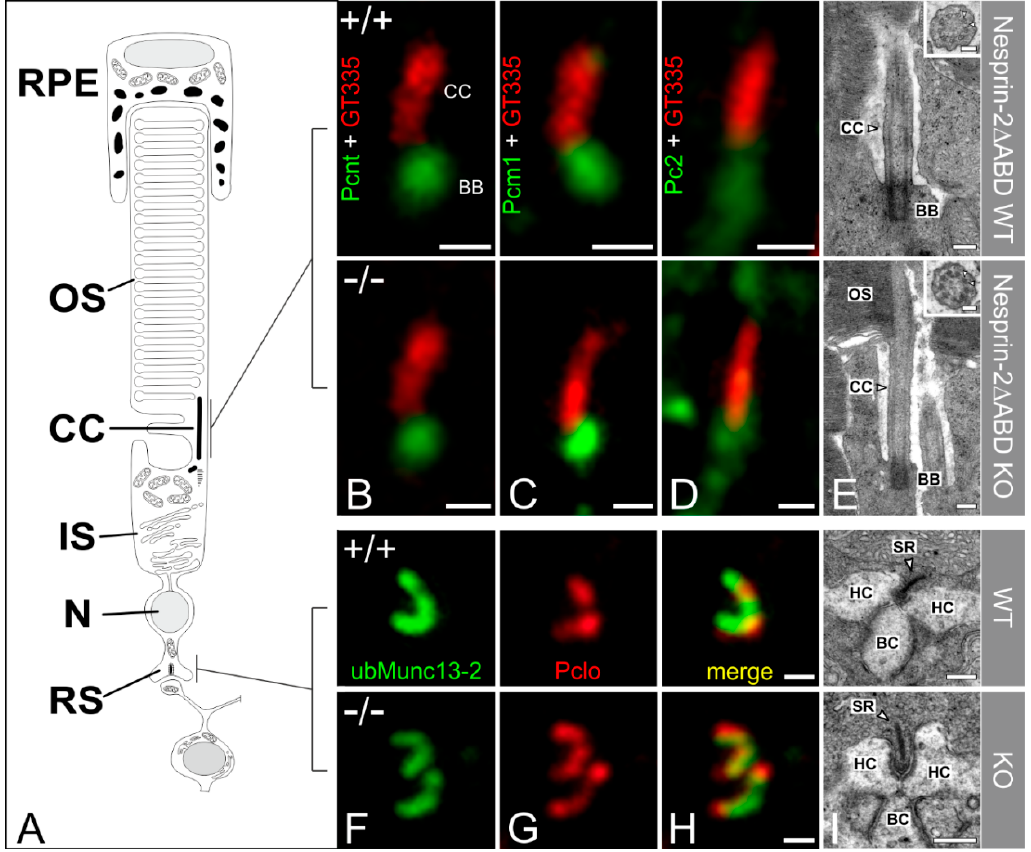
Figure 3. High-resolution microscopical analysis of the basal body complex and the ribbon synapse of Nesprin-2 (cid:52) ABD mouse strain (age 2–4 month). ( A ) Scheme of a vertebrate rod photoreceptor. ( B – D ) Photoreceptors connecting cilia (CC) of wild-type and knockout Nesprin-2 ∆ ABD mouse retinae double-labeled with antibodies against Pcnt (B, MmPeriC1, green), Pcm1 (C, green), or Pc2 (D, green) as markers for the basal body complex (BBC) and polyglutamylated tubulin (GT335, red) as a marker for the ciliary apparatus. Pcnt and its interaction partners are localized at the BBC of the connecting cilium of the photoreceptor in wild-type and knockout Nesprin-2 ∆ ABD retinae. ( E ) Representative electron micrographs of rod photoreceptor terminals, processed for best tissue preservation. ( F – H ) Presynaptic ribbon complex of wild-type and knockout Nesprin-2 ∆ ABD mouse retinae labeled with antibodies against ubMunc13-2 and Piccolo. ( I ) Representative electron micrographs of rod photoreceptor terminals processed for best tissue preservation. The comparison of wild-type and knockout Nesprin-2 ∆ ABD shows no ultrastructural alterations. Scale bars: 0.5 µ m ( B – D ), 0.5 µ m ( H ), 0.25 µ m ( E , I ), 0.1 µ m higher magnification views ( E